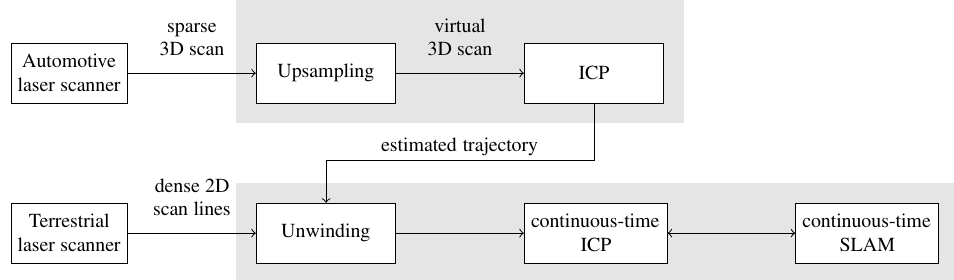
Figure 3. workflow of our backpack